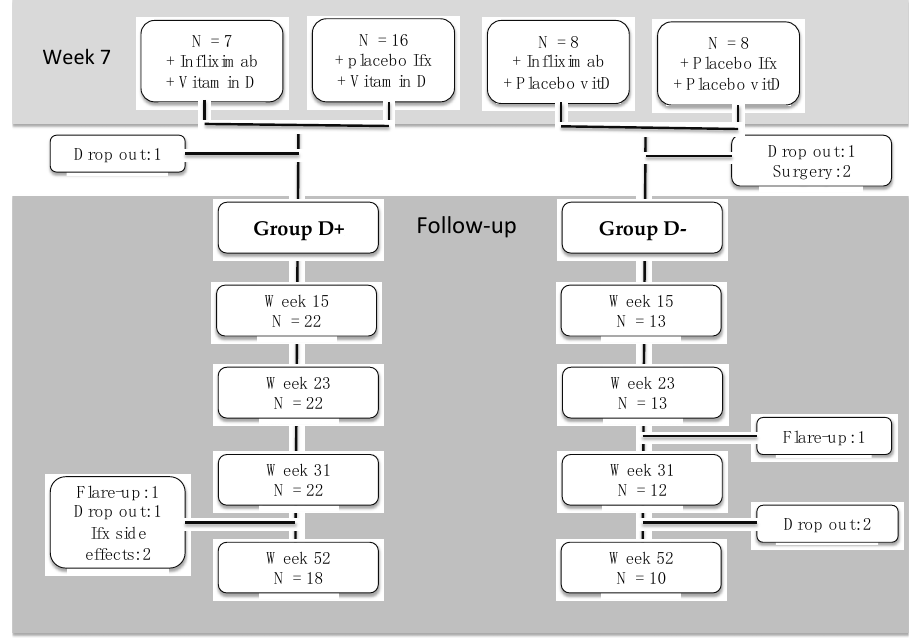
Figure 1. Patient flow from end of intervention study to follow-up week 52. Patients were ex- cluded when discontinuing infliximab treatment. Ifx; infliximab, vitD; vitamin D, N;